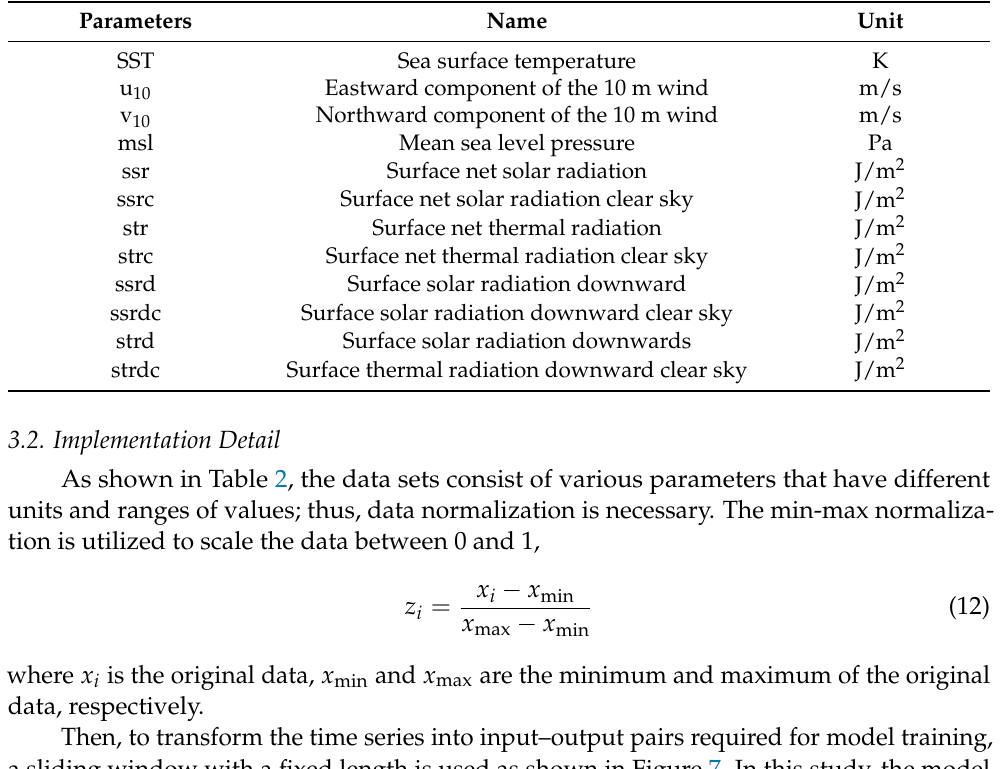
Table 2. Variables affecting SST distribution and